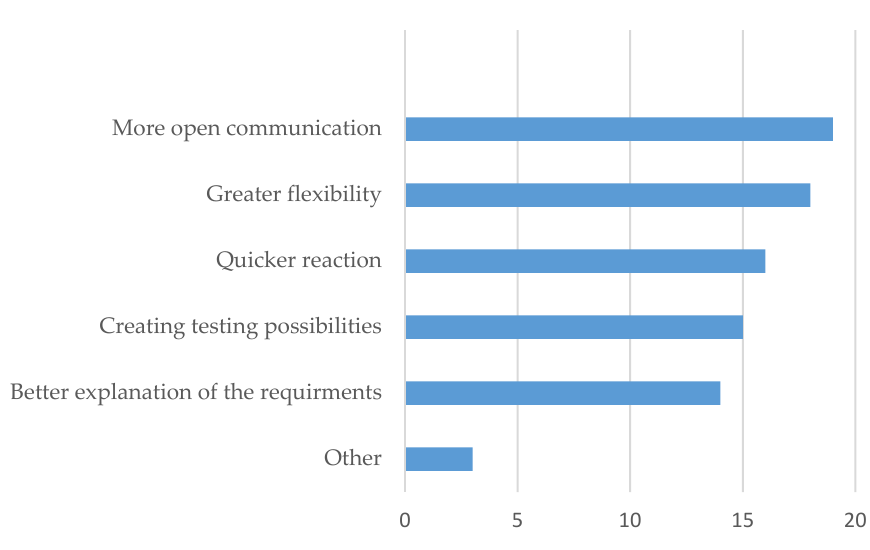
Figure 2. Relevance of regulators’ support in the implementation of new FinTech solutions, number of answers.